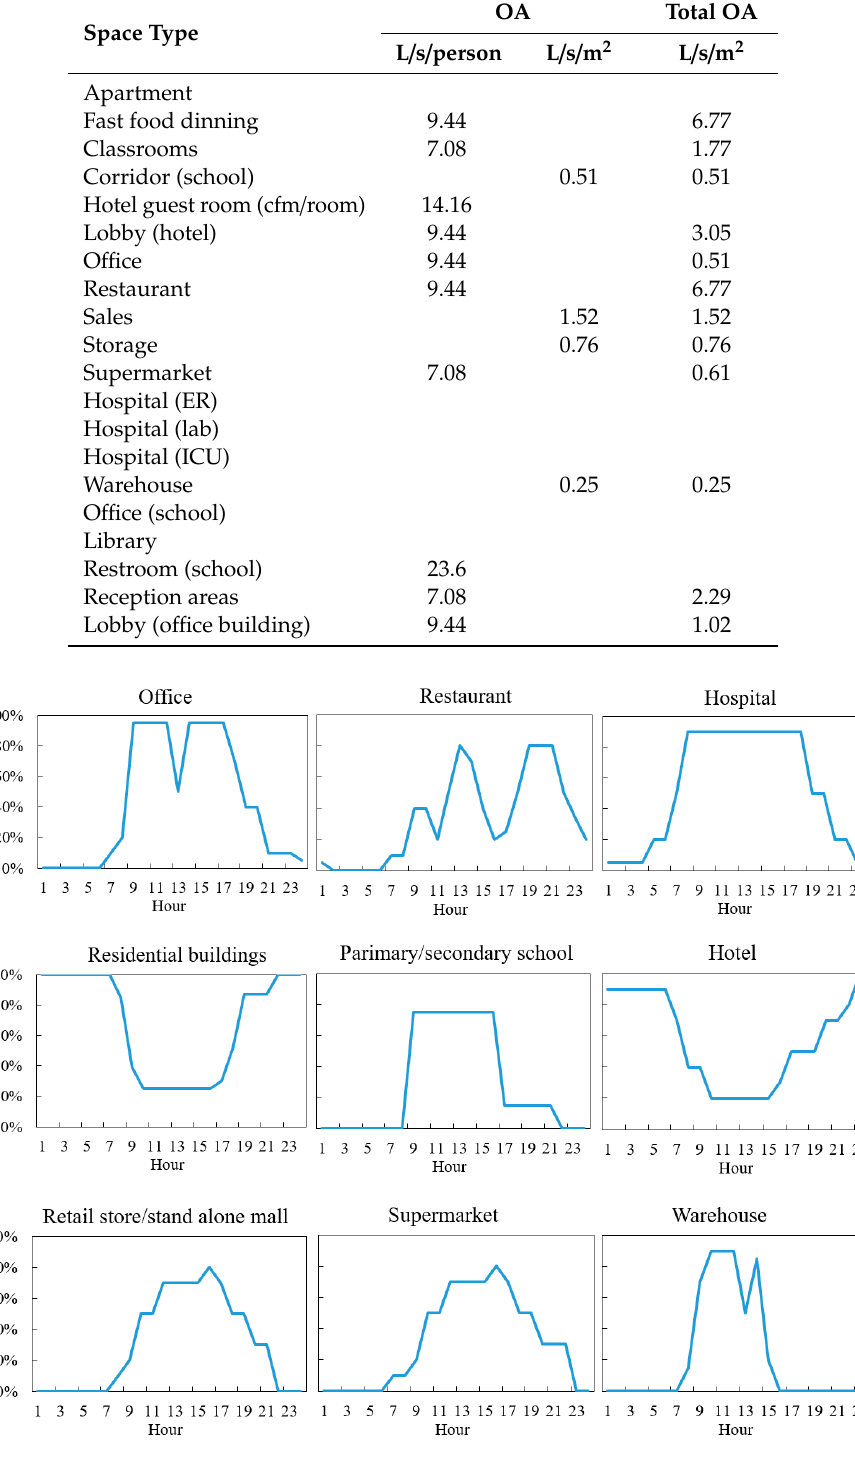
Figure 5. Building weekday hourly occupancy schedules.